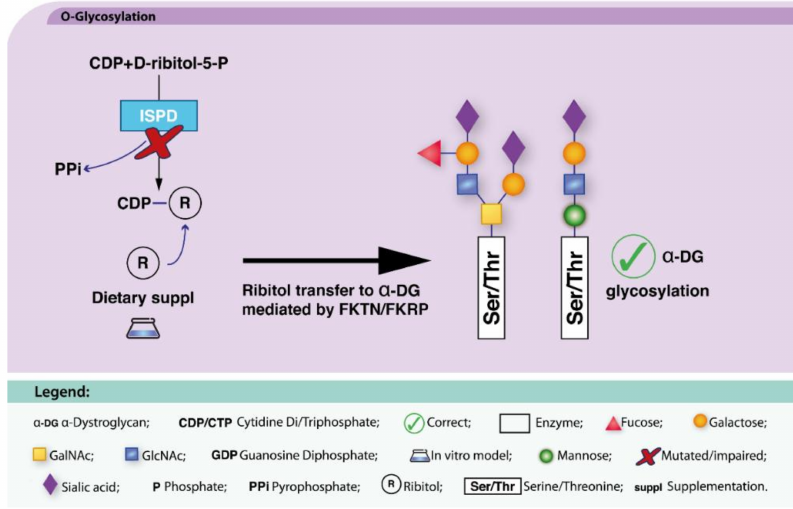
Figure 6. Dietary supplementation approaches under investigation for ISPD-CDG. ISPD synthetizes CDP-ribitol from CDP and D-ribitol-5-P, with the release of PPi (black and blue arrows). Ribitol supplementation (blue arrow) aims to circumvent ribitol shortage and ultimately the recovery of α -DG glycosylation (bold back